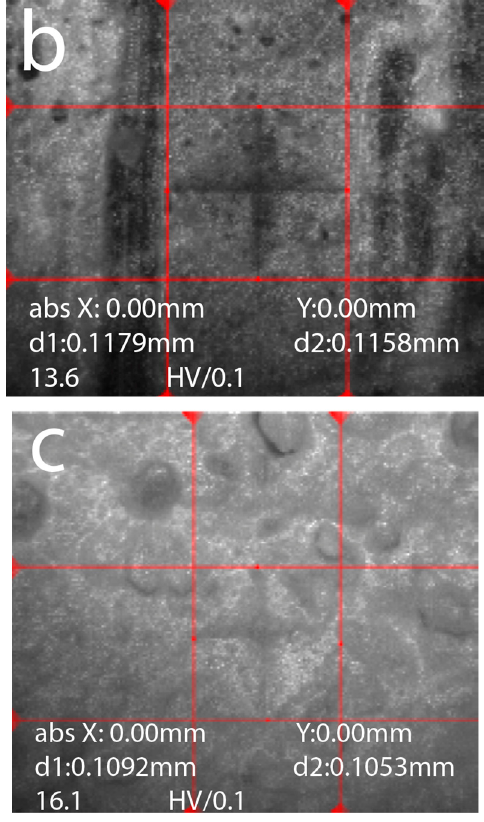
Figure 11. Image of the imprint of microhardness tester indentor when measuring microhardness at a load of 100 g on the surface of polymeric binder ( a ) and composites with wheat straw with the filler content: ( b )—30 wt.%; ( c )—50 wt.% .